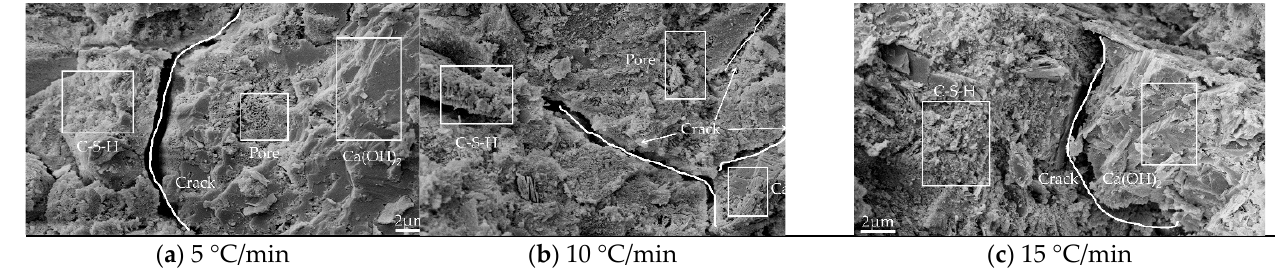
Figure 9. Microtopography and pore structure images of mortar heated (400 °C): ( a ) 5 °C/min; ( b ) 10 °C/min; ( c ) 15 °C/min.